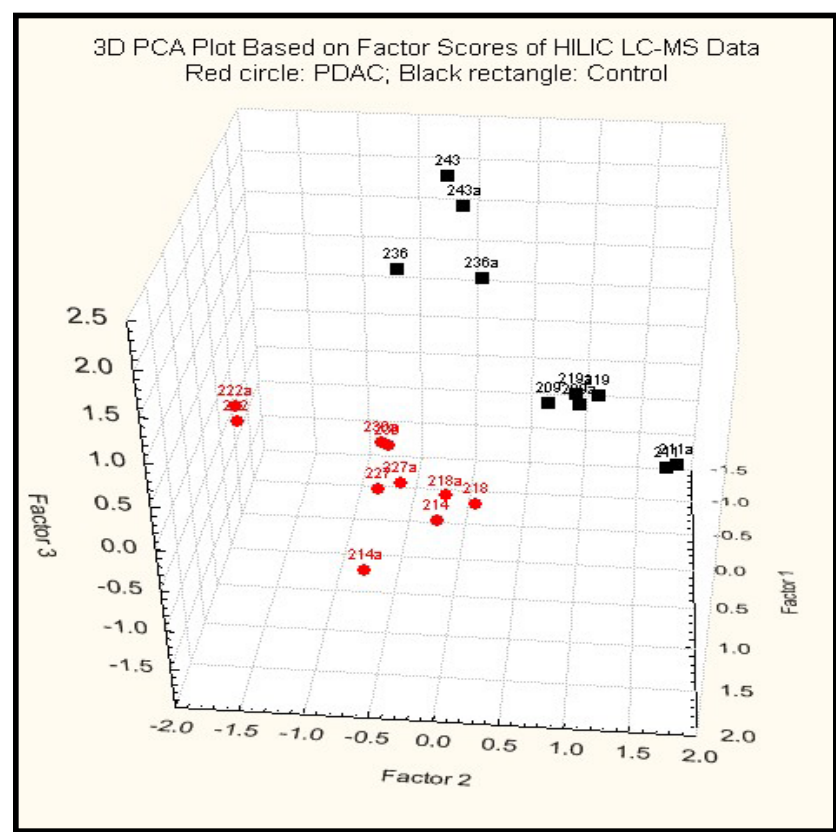
Groups in the right panel were color-coded as: 1—red (PDAC), 2—black (normal & chronic